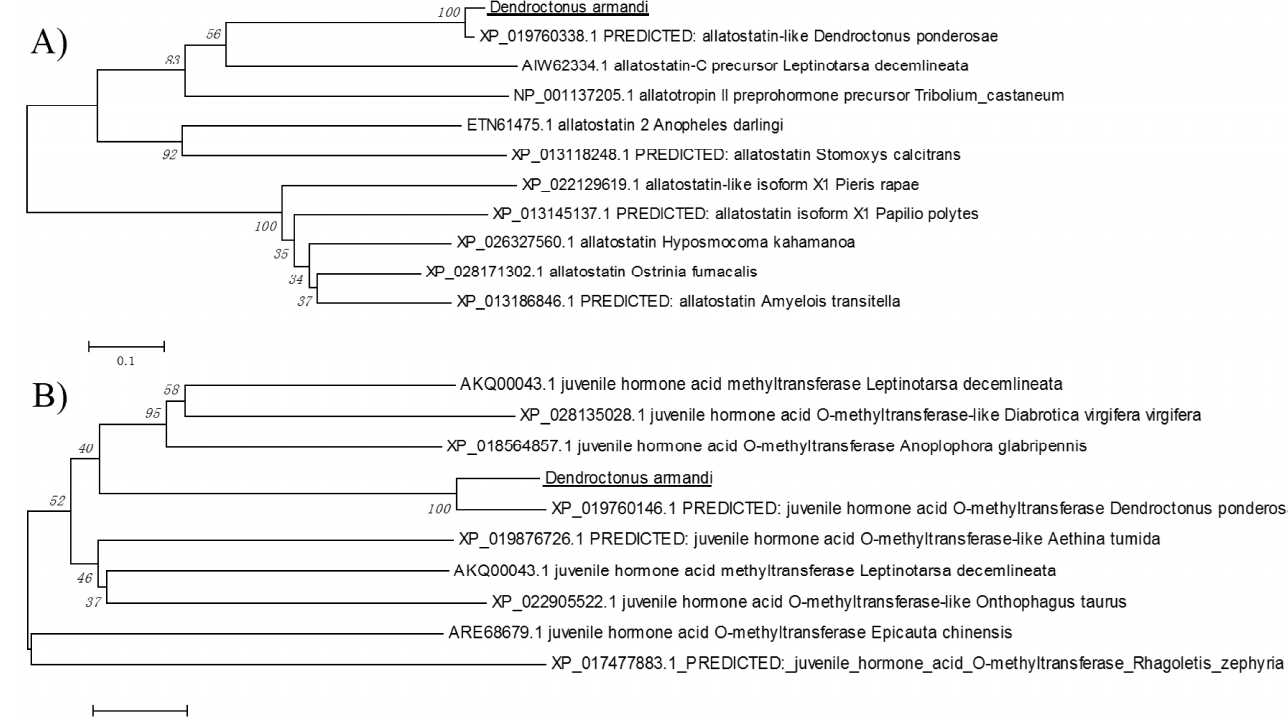
Figure 1. Phylogenetic tree of allatostatin ( DaAST ) and juvenile hormone acid O-methyltransferase ( DaJHAMT ) from Dendroctonus armandi . ( A ) Phylogenetic analysis of DaAST ; ( B ) Phylogenetic analysis of DaJHAMT . The two sequences from D. armandi are marked in black. The phylogenetic trees were constructed with MEGA7.0 using the neighbor-joining method. Values indicated at the nodes are bootstrap values based on 1000 replicates. Table 1. Amino acid identity of putative allatostatin ( DaAST ) and juvenile hormone acid O-methyl- transferase ( DaJHAMT ) with related sequences in other insect species.